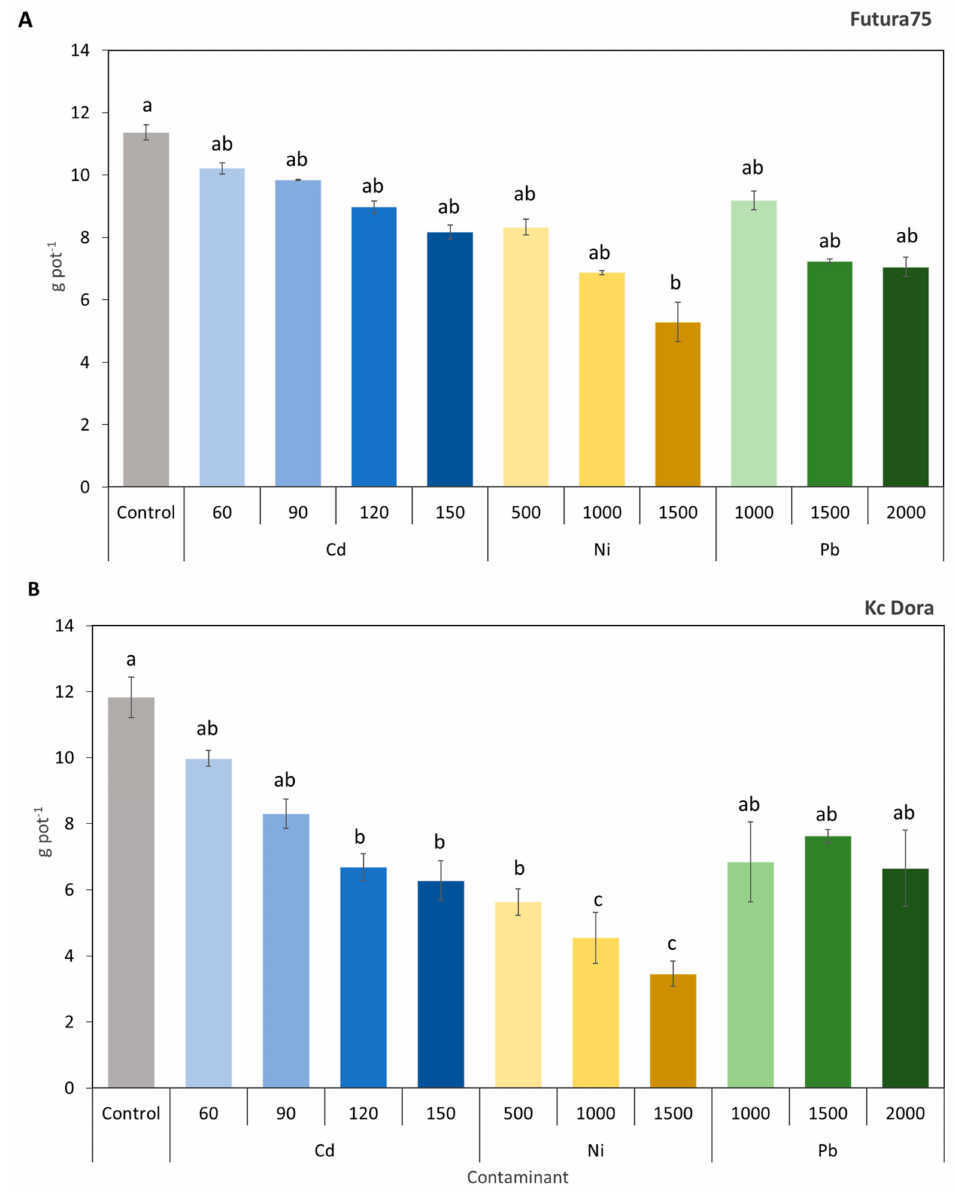
Figure 1. Aboveground biomass of Futura 75 ( A ) and KC Dora ( B ). Different letters indicate significant differences between the means (according to HSD at p ≤